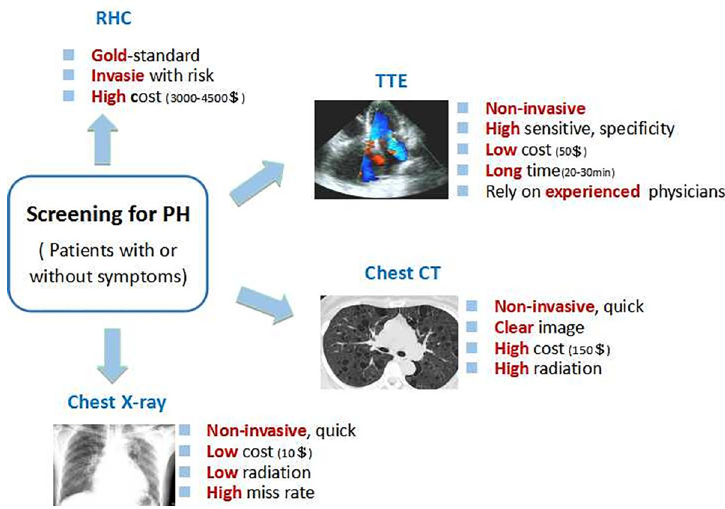
Fig 5. Comparision of the advantage and defect of different ways to screen spicious PH patients. PH, pulmonary hypertension; RHC, right heart catheterization; TTE, transthoracic echocardiography; CT, computed tomography.